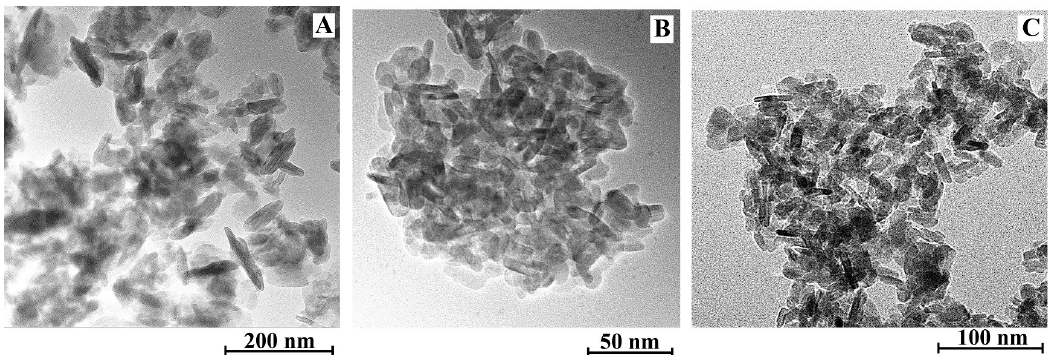
Figure 2. XRD patterns of the CuS prepared in the [C 4 C 2 OOHim]NTf 2 /water systems.